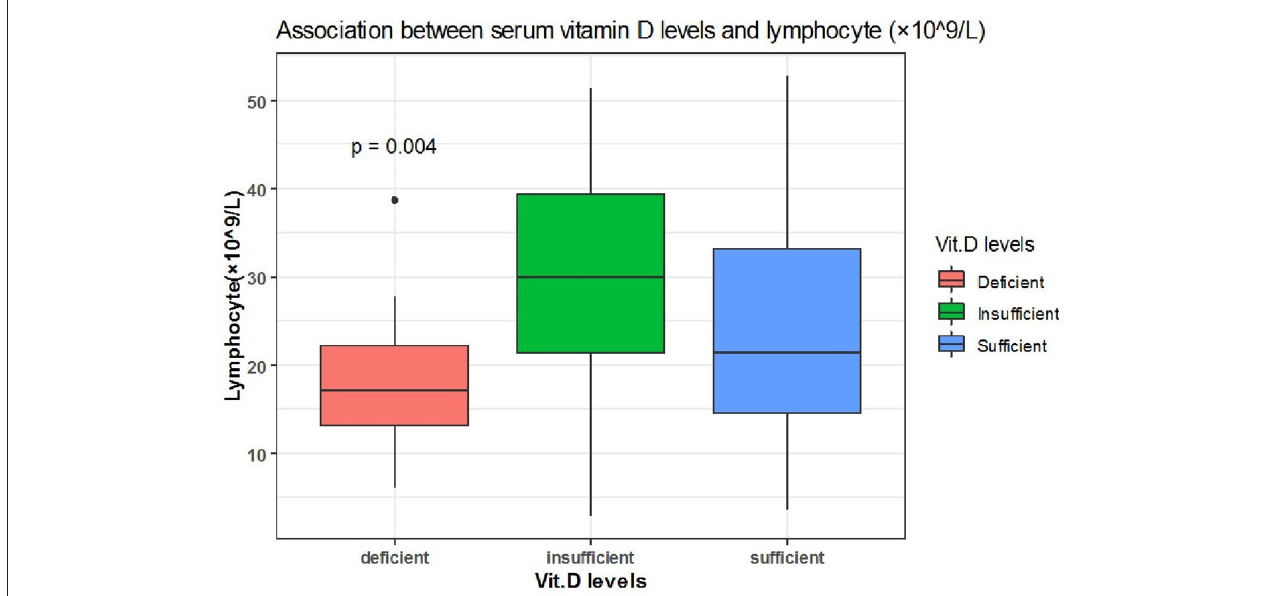
FIGURE 3 | The association between serum 25(OH)D levels (sufficient, insufficient, deficient) and lymphocyte ( × 10 9 /L).